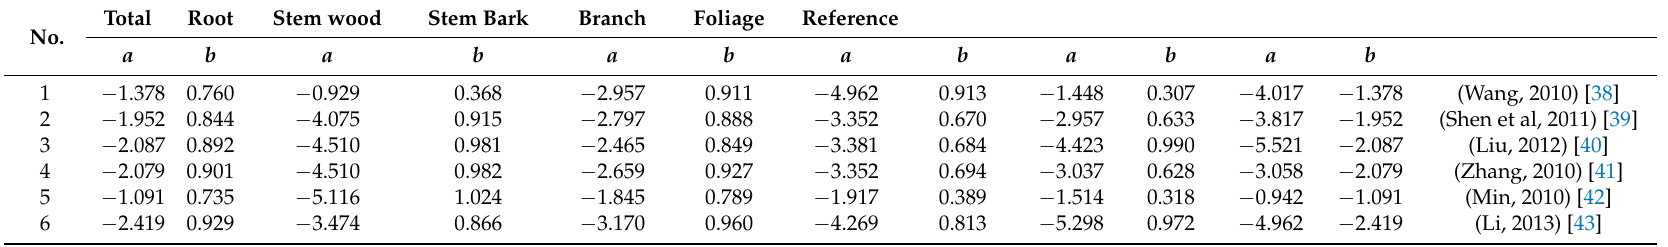
Table A1. a and b values of 36 biomass equations(total, root, stem wood, stem bark, branch, and foliage biomass) in six reports for larch in